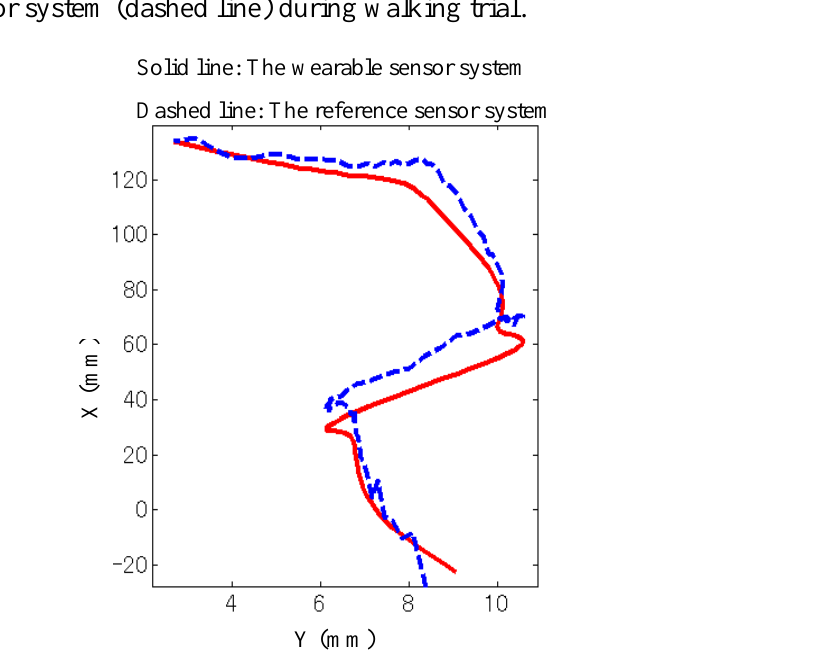
Figure 4. Centre of pressure (CoP) measured by the wearable sensor system (solid line) and reference sensor system (dashed line) referred to a global coordinate system. and referenced sensor system (dashed line) during walking